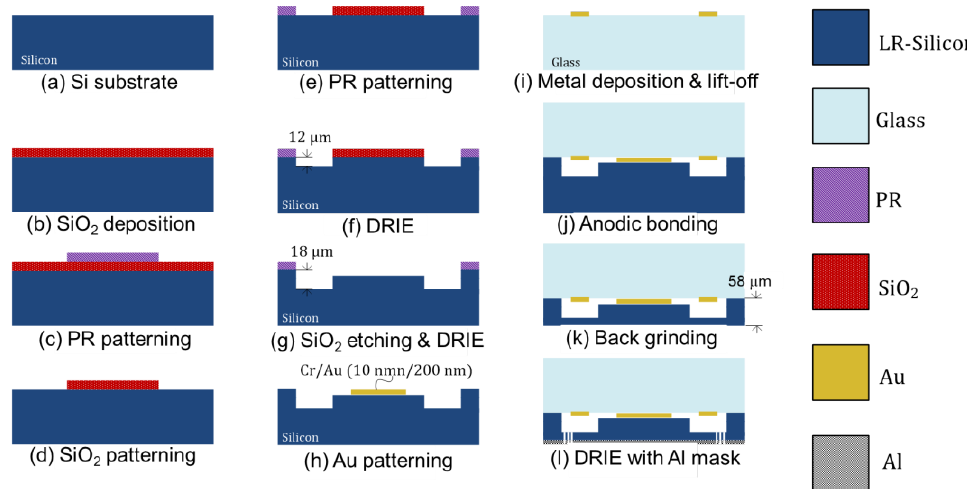
Figure 5. Fabrication process flow for vertical MEMS actuator.